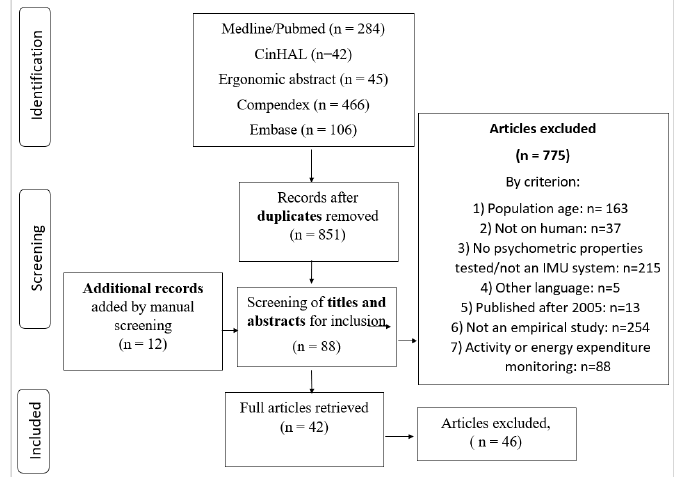
Figure 2. Flow chart of systematic review process.